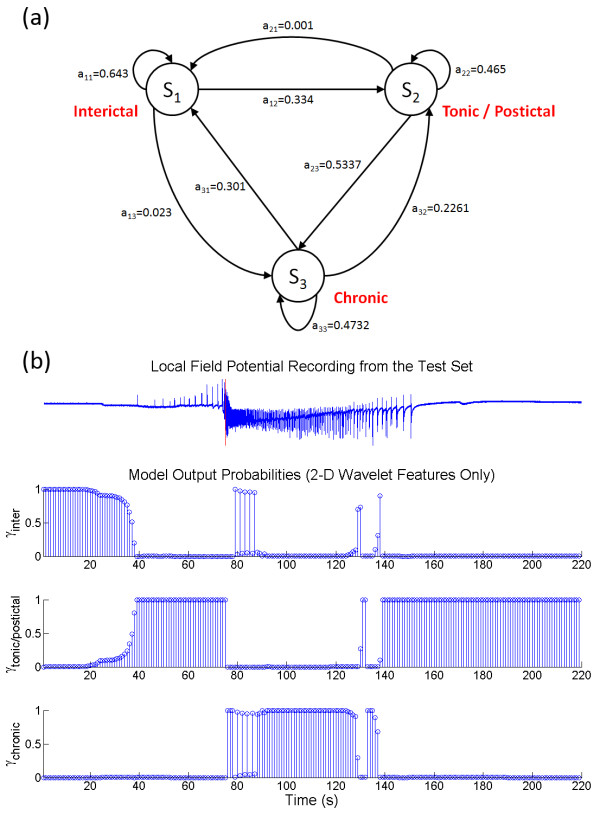
The transition diagrams and the posterior probabilities of the reduced feature space after mRMR and AICc. (a) A bidirectional sequence of state progress is found where the HMM is not able to distinguish between tonic firing and postictal activities. (b) The mapping of the HMM output to the experimental data is shown. The tonic firing phase prior to the chronic seizure and the postictal activity are represented by the same model state. Because the state transition probability from the tonic/postictal state is extremely small (0.001), it would take much longer for the interictal activity right after chronic seizure to be classified correctly.